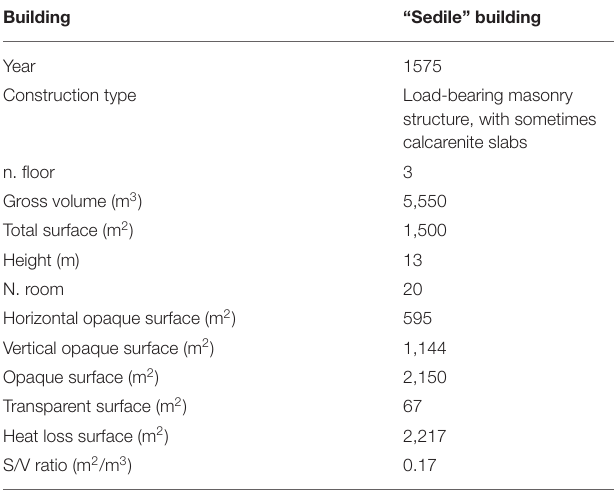
TABLE 1 | Geometric parameters and dispersing